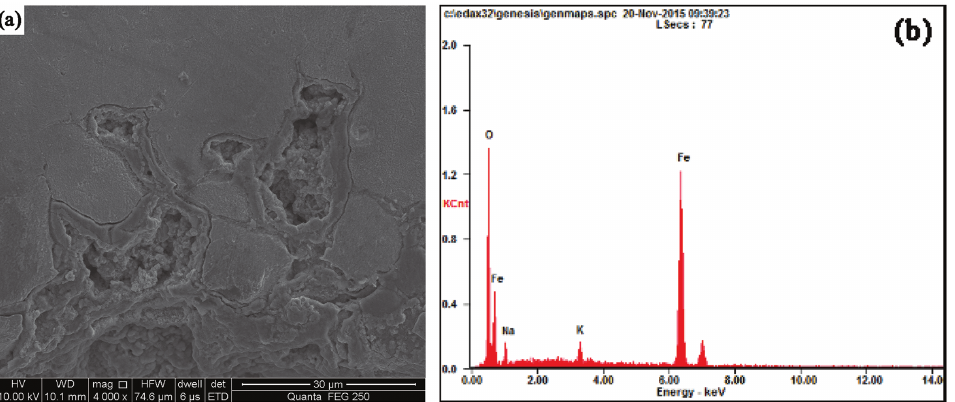
Figure 10: Micrograph of the detailed morphology on (a) corroded grains and the (b) EDS analysis on grain boundaries at